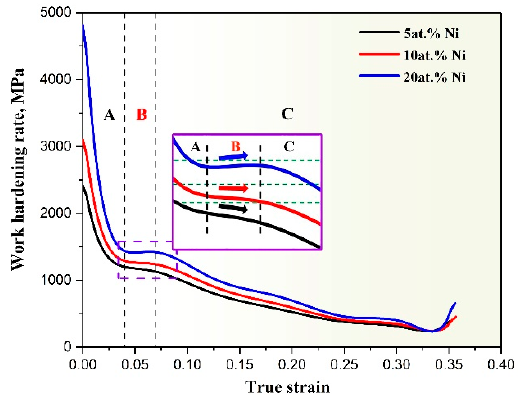
Figure 3. The curves of the work-hardening rate vs the true strain for Cu – Ni alloys.